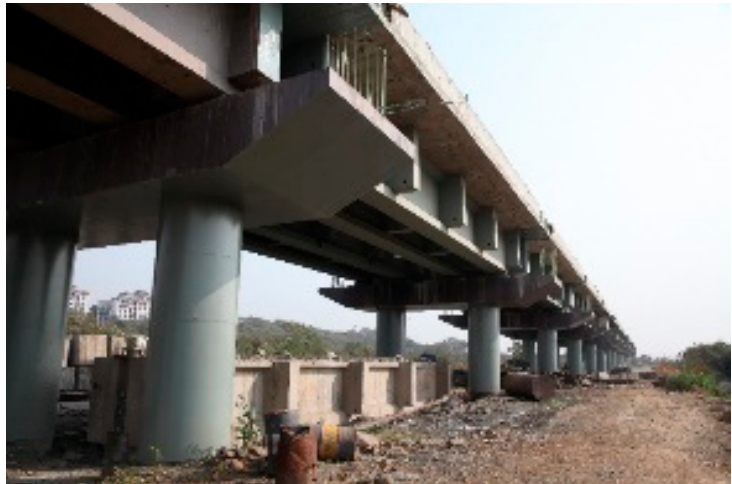
Figure 3. Sensors on side wall.